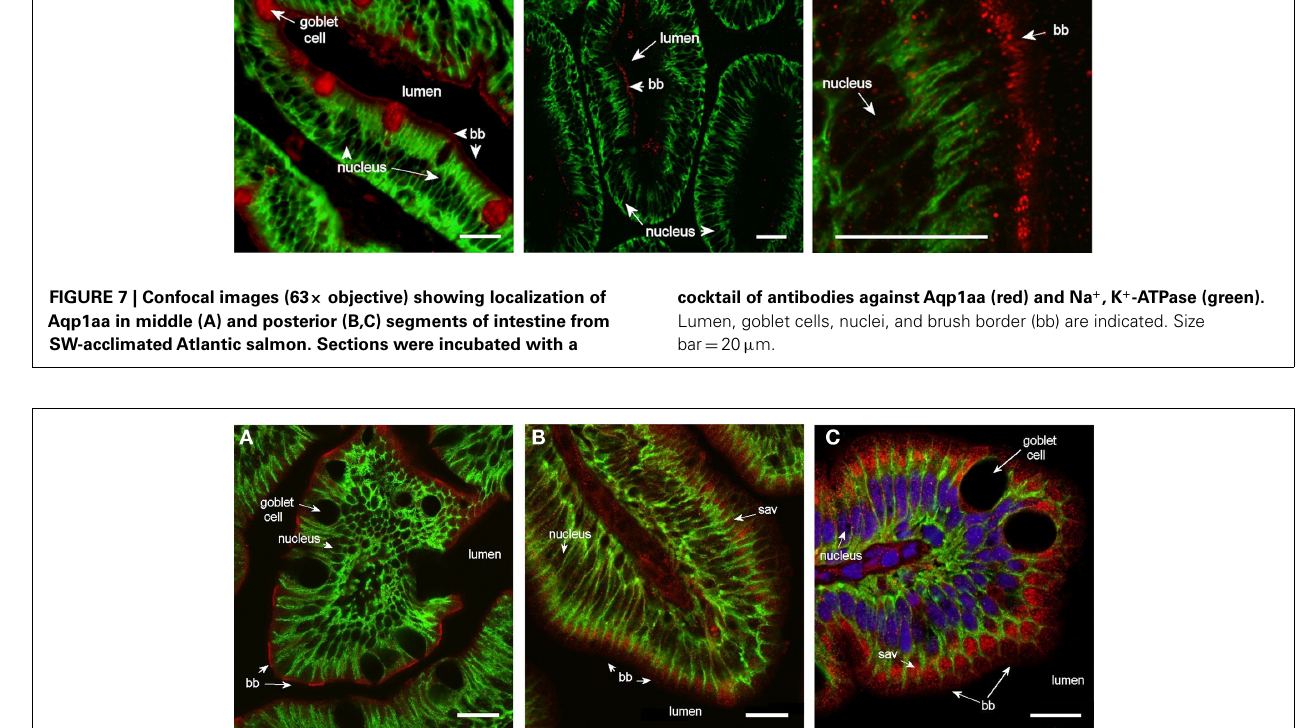
ileo-rectal valve. Sections were incubated with a cocktail of antibodies against Aqp1ab (red), Na + , K + -ATPase (green), and nuclei were counterstained with DAPI [blue, only in (C) ]. Lumen, goblet cells, nuclei, brush border (bb), and sub-apical vesicles (sav) are indicated. Size bar = 20 μ